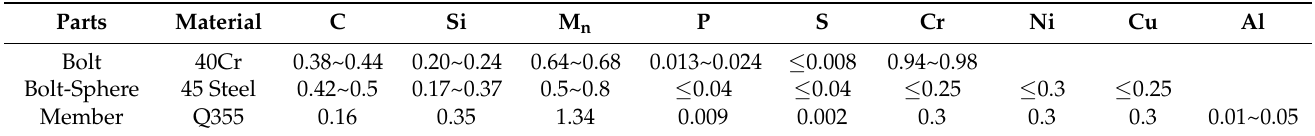
Table 3. Chemical composition of the parts (wt%).